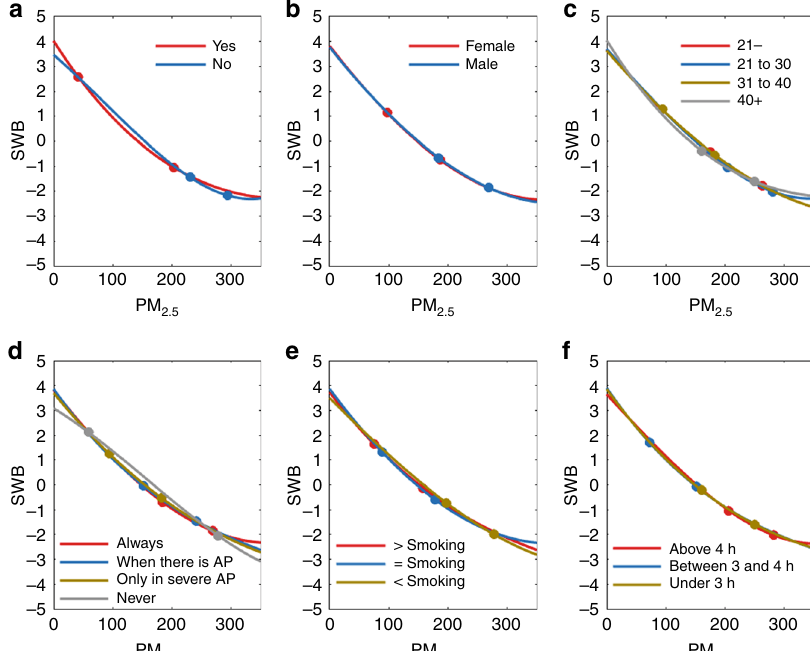
Fig. 2 Polynomial fi tting of air pollutants and subjective well-being in social groups. a The effect of whether or not people have children on their SWB under air pollution (red refers to yes, and blue refers to no). b Gender has little effect on people ’ s SWB (red refers to female and blue refers to male). c The effect of age group on SWB (red refers to people younger than 21; blue refers to people between 21 and 30; brown refers to people between 31 and 40; grey refers to people older than 40). d The effects of attitude towards the necessity of wearing a mask on SWB (red refers to people who always wear masks; blue refers to people who wear masks when there is air pollution; brown refers to people who wear masks only during severe air pollution; grey refers to people who never wear masks when going outside). e The effect of knowledge of the harmfulness of air pollution on SWB (red refers to people who think the harmfulness of air pollution is more serious than smoking; blue refers to people who think the harmfulness of air pollution is similar to smoking; brown refers to people who think the harmfulness of air pollution is less serious than smoking; grey refers to people who think air pollution is harmless and causes only discomfort). f The effect of the average daily exposure time to outdoor air on SWB (red refers to people who stay outdoors less than 3 h each day; blue refers to people who stay outdoors between 3 and 4 h each day; brown refers to people who stay outdoors more than 4 h each day). See raw z-score data in Supplementary Fig.